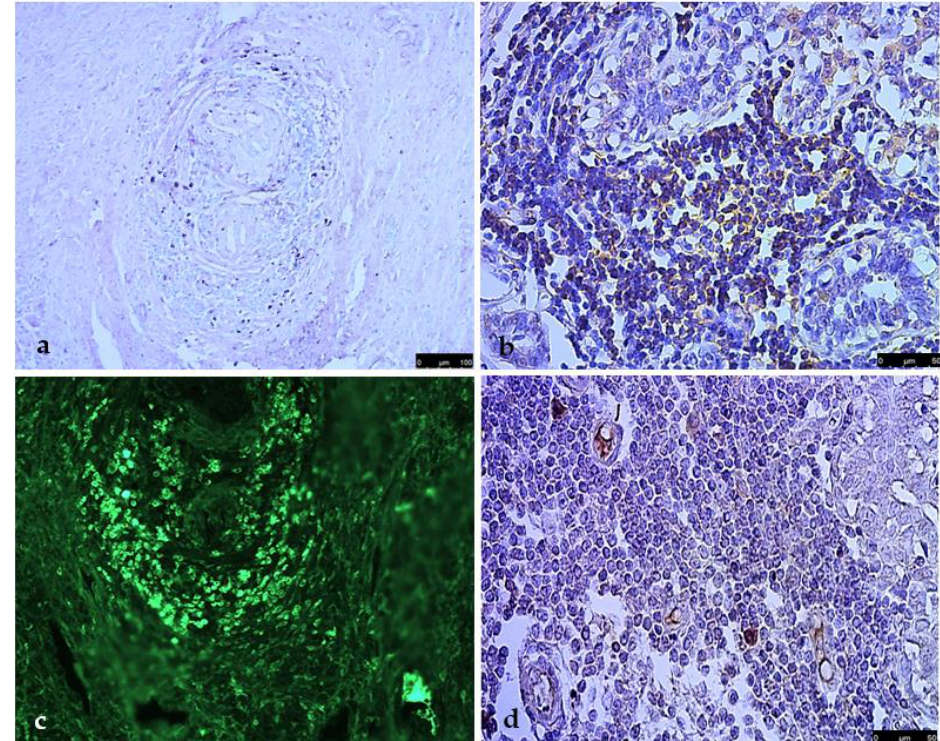
Figure 5. In the follicle-like structures, T lymphocytes are mainly located in the outermost areas in a concentric pattern (( a ), CD3, Vector Vip, 10 × ), CD20+ cells are in the inner part (( b ), DAB, 20 × ). The remaining inflammatory population reveal an intense positivity for the IgG marker (( c ), FITC, 20 × ). The presence of vascular structures such as HEVs is confirmed by positivity for MECA-79 (( d ), DAB, 20 × ).